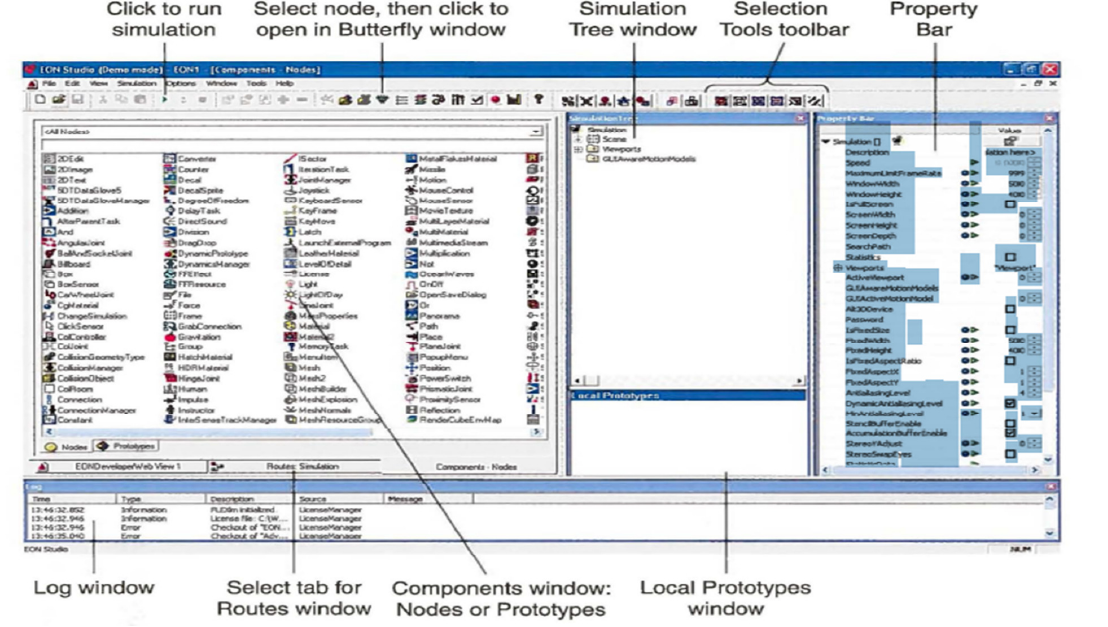
Fig. 3. EON Studio default